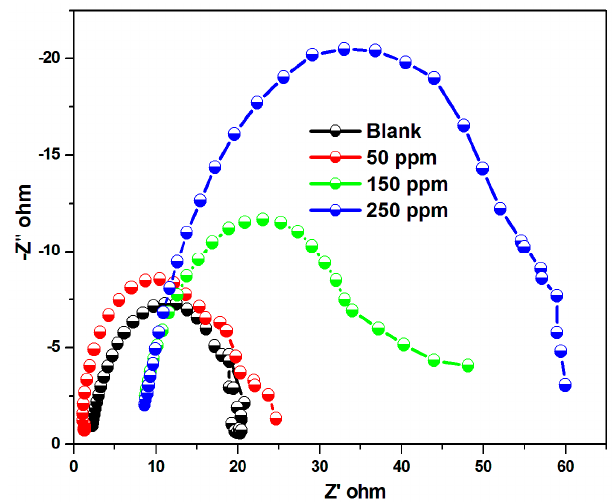
Figure 4. Impedance for MS specimen in 1M HCl with and without various concentrations of T. aralioides